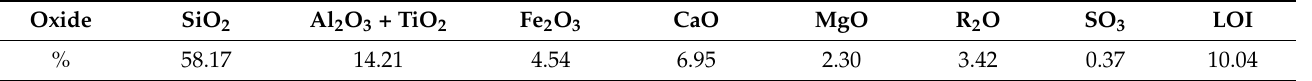
Table 1. Chemical composition of